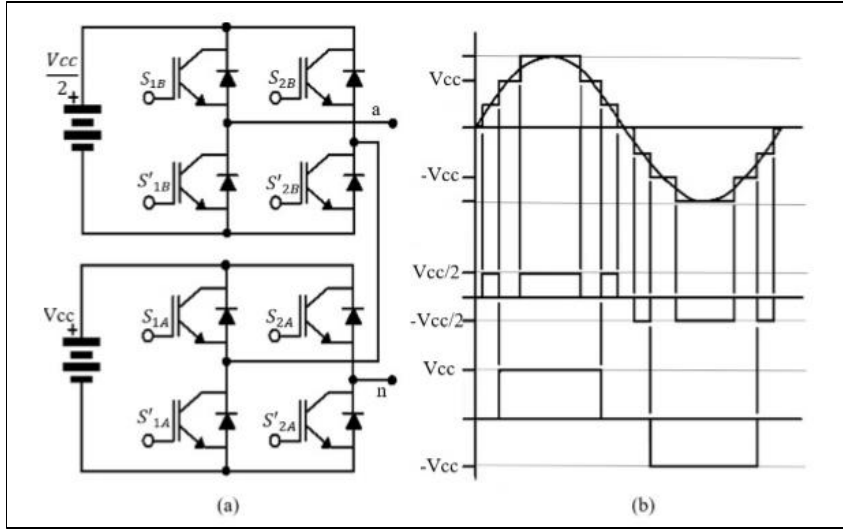
Figure 3: (a) Inverter topology in cascade with asymmetric sources, (b) Waveform for 7 levels. Source: [9].